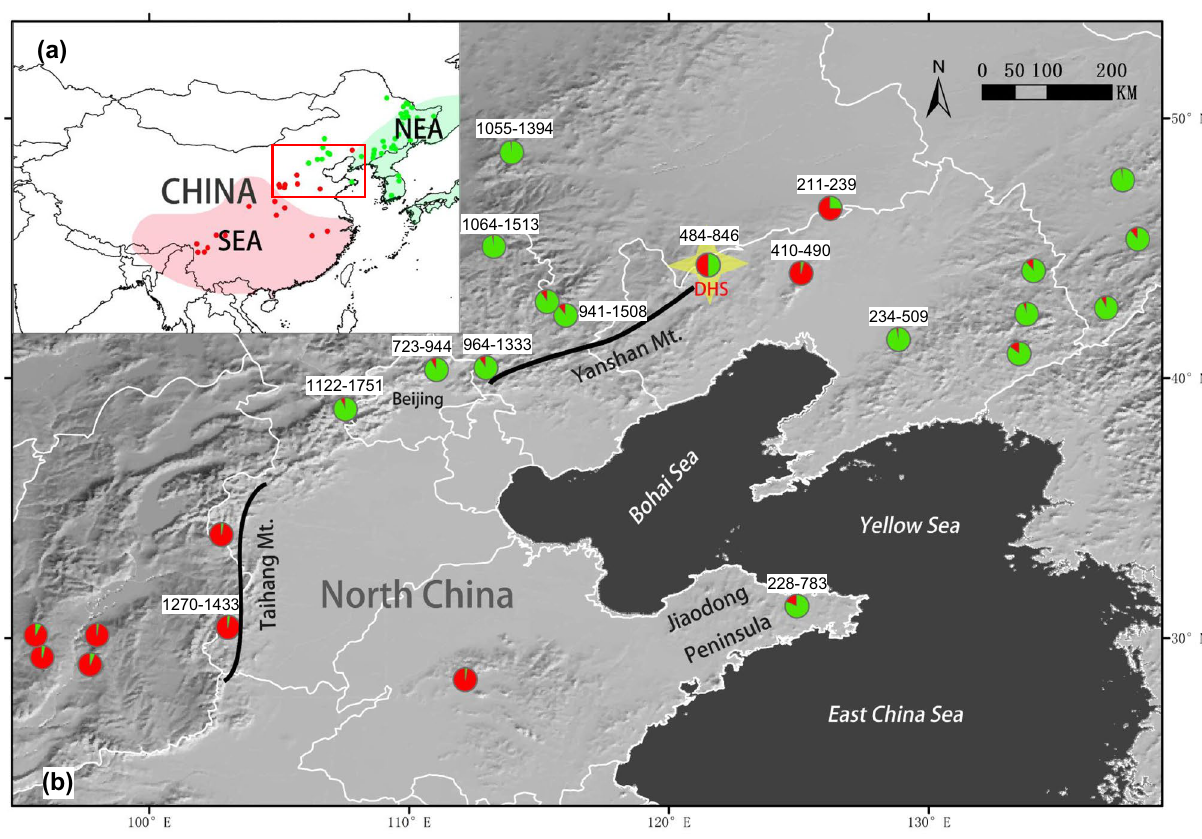
Figure 1. Geographical range of NEA-SEA lineages area and the sampling population locations in North China from GUO et al. 2014. ( a ) Geographical range of two Tertiary relict regions [Southern East Asia (SEA) and Northern East Asia (NEA)] for temperate flora in East Asia, according to Milne and Abbott 5 . The red and green points indicate SEA and NEA Acer population locations sampled by Guo et al. 10 . ( b ) An enlarged representation of the area demarcated by the red border in ( a ) showing the geography of North China, which is a key secondary contact zone for tertiary relict NEA and SEA lineages. Colored circles indicate the locations of Acer populations. The pie charts of the sampled populations are STRU CTU RE results based on a whole-range dataset (see text), with the red and green sectors representing the SEA and NEA lineages, respectively. The numbers adjacent to the circles denote the altitudinal range in meters for all sampled individuals in the population. The focal population in the Daheishan National Nature Reserve examined in this study is indicated by the yellow star. ArcGIS 10.1 software was used for mapping (https:// www. esri. com/ en- us/ arcgis/ about- arcgis/ overv